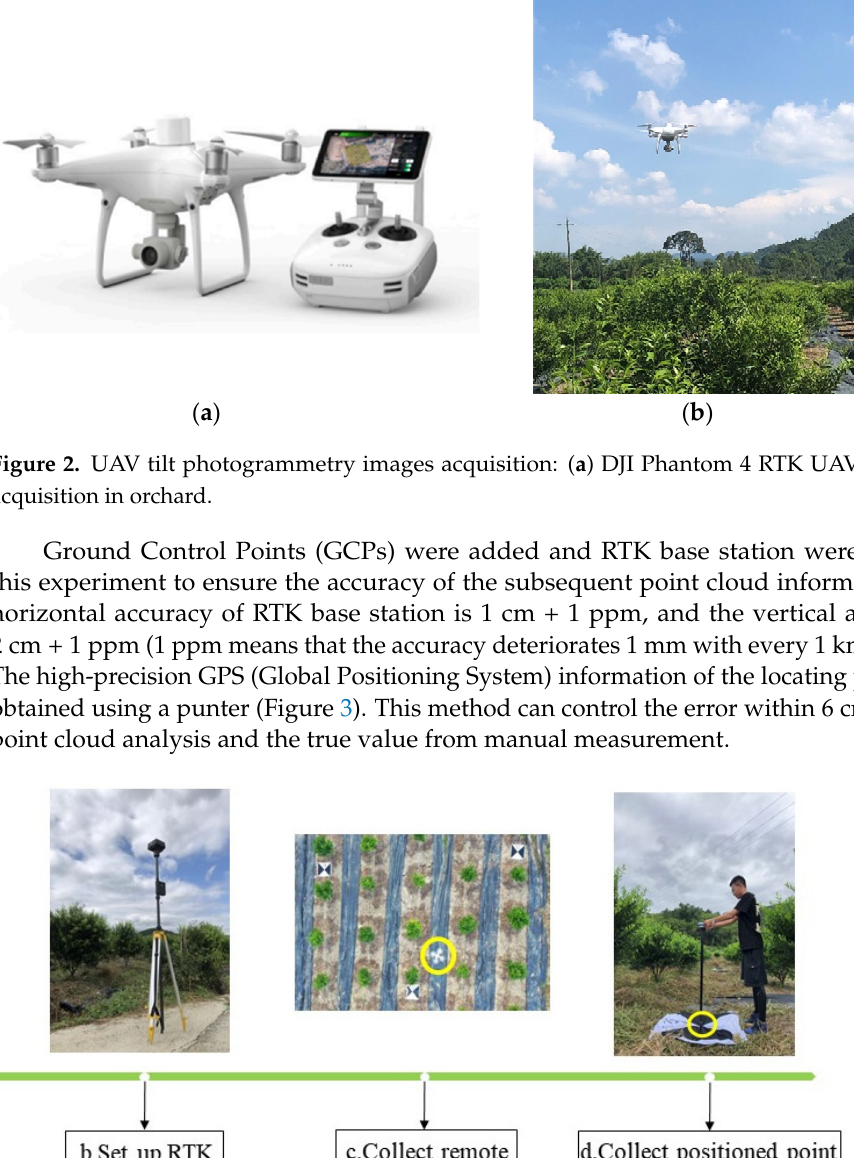
Figure 1. Experimental site.